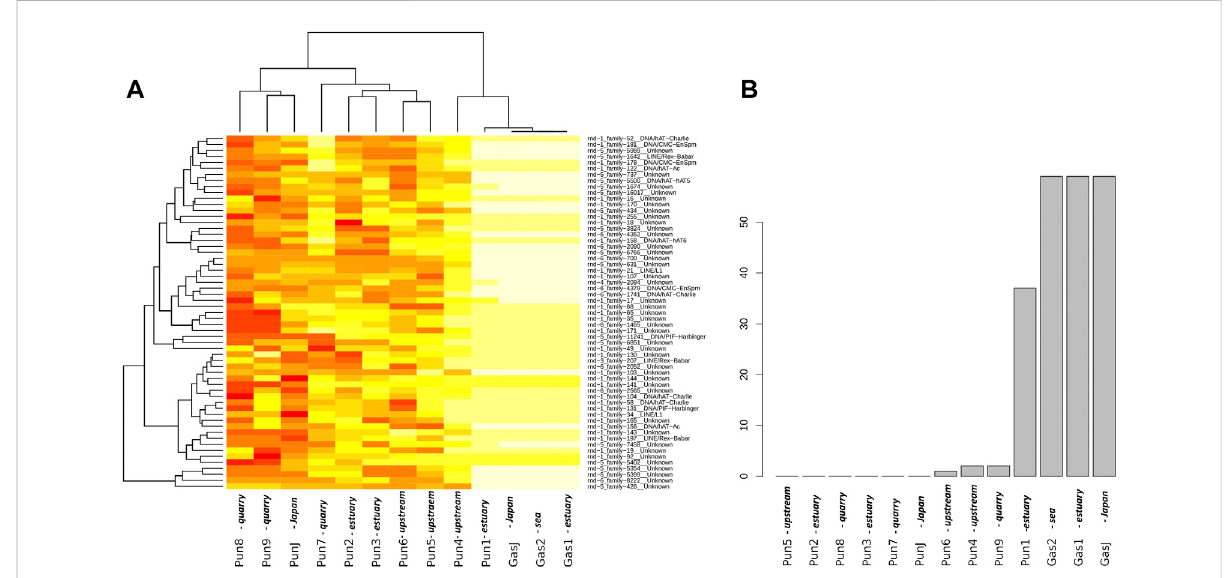
FIGURE 3 Analysis of transposable elements speci fi c to the three-spined stickleback (A) Heatmap of transposable element (TE) representation. Columns of the heatmap correspond to specimens, whereas rows correspond to transposable element families present in specimens. The red color on the heatmap indicates low coverage of the corresponding transposable element, whereas the white color shows high coverage. (B) Numbers of “ three- spined ” TE families present in specimens from the White Sea populations. Only TEs that were fully covered by sequencing reads and had a high mapping depth were taken into account. The specimens were sorted according to the number of TE families present. White Sea stickleback populations are marked as quarry, upstream, estuary, and sea according to the sampling